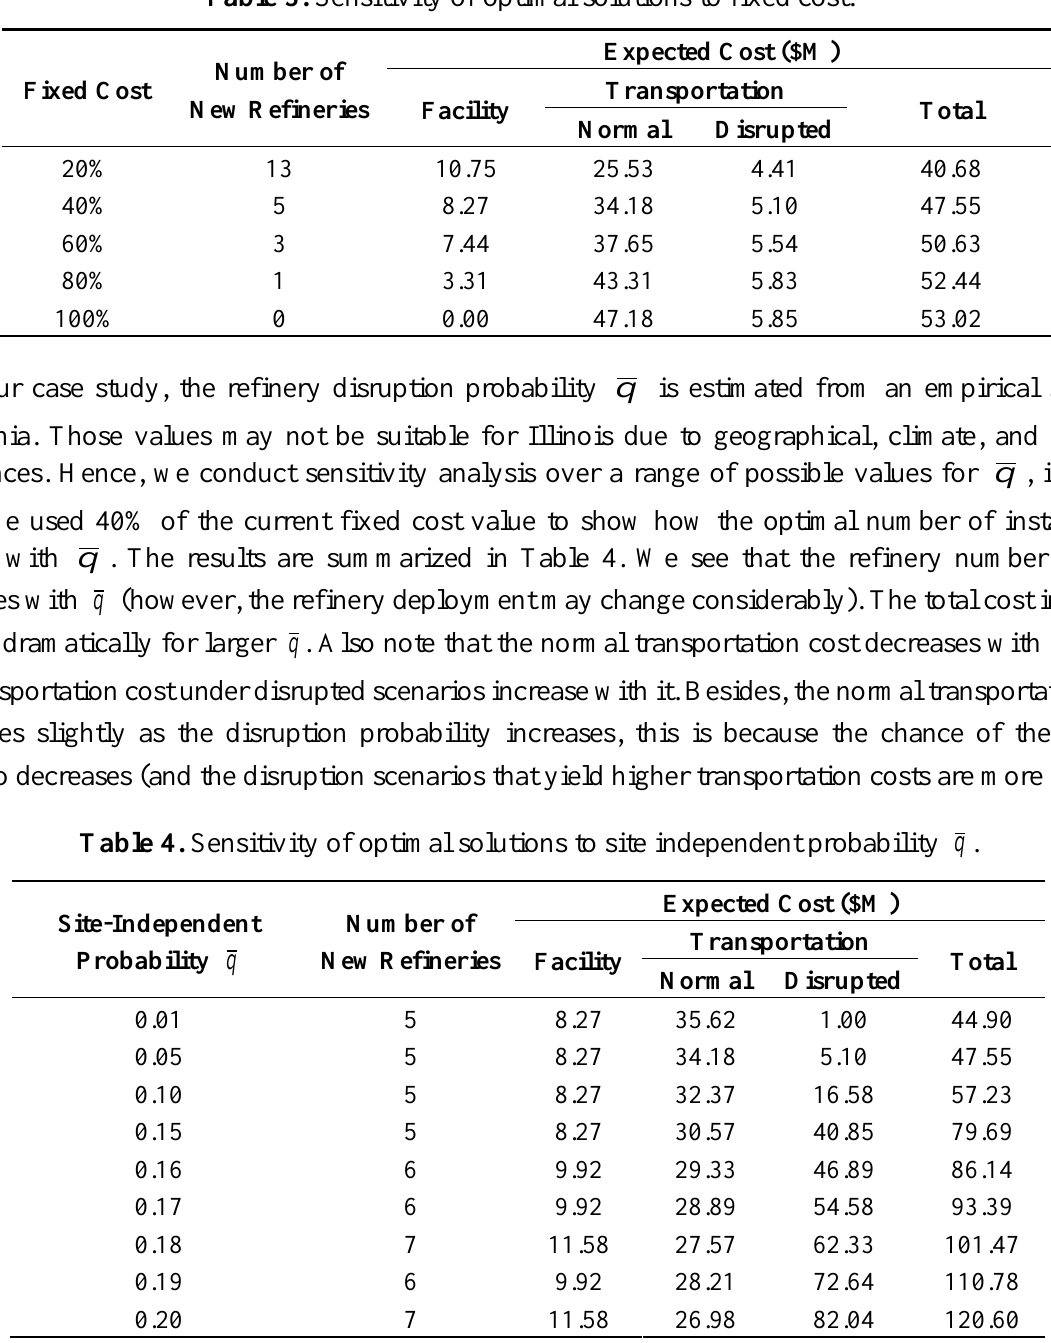
Table 3. Sensitivity of optimal solutions to fixed cost.